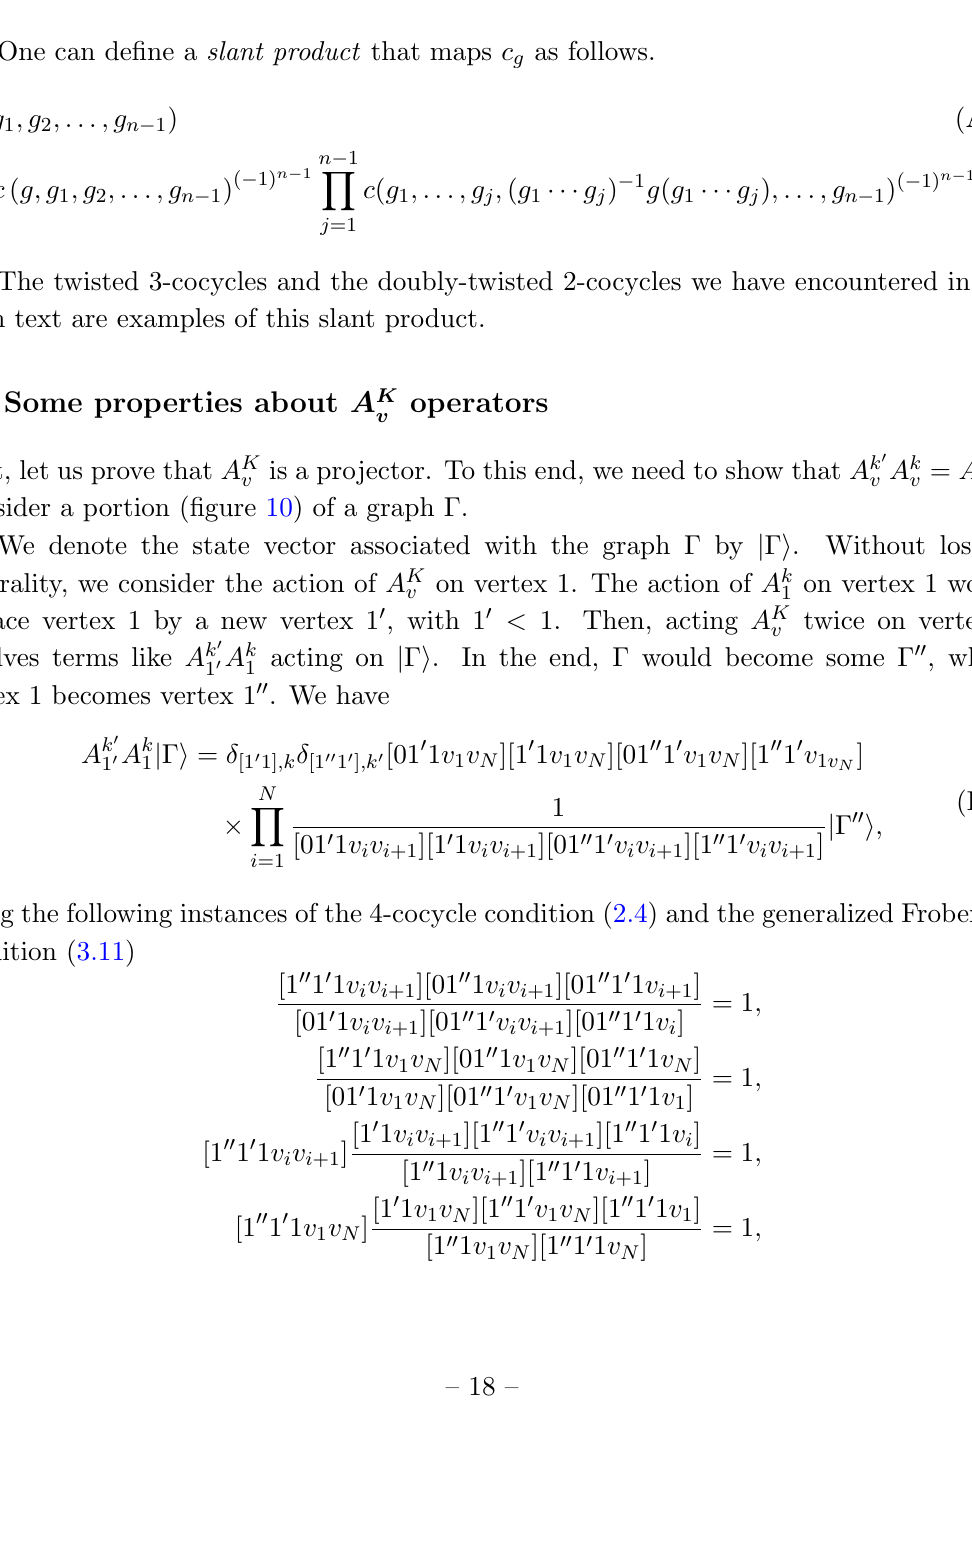
Figure 10. A portion of a graph, where some boundary vertices { 1 , v 1 , v 2 , . . . , v N } and a bulk vertex 0 are shown. We assume that v i +1 > v i >